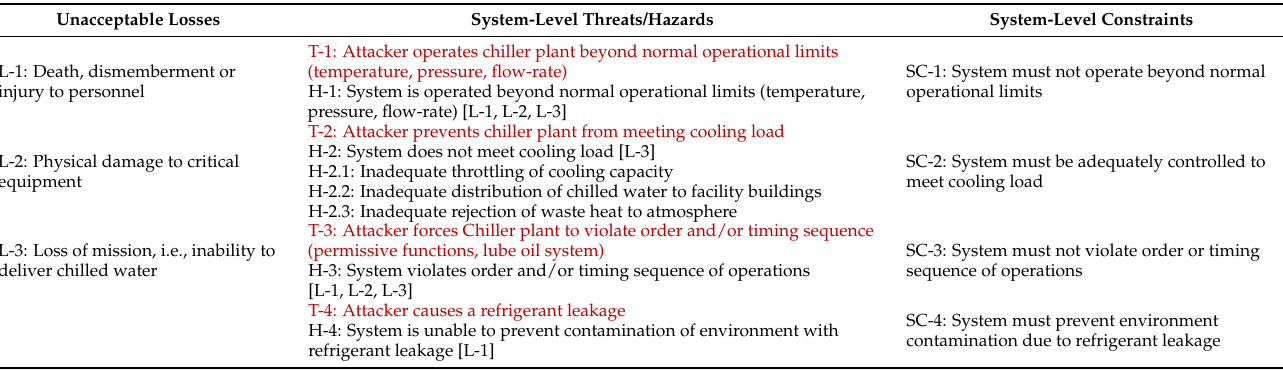
Table 1. System-level Losses, Hazards and